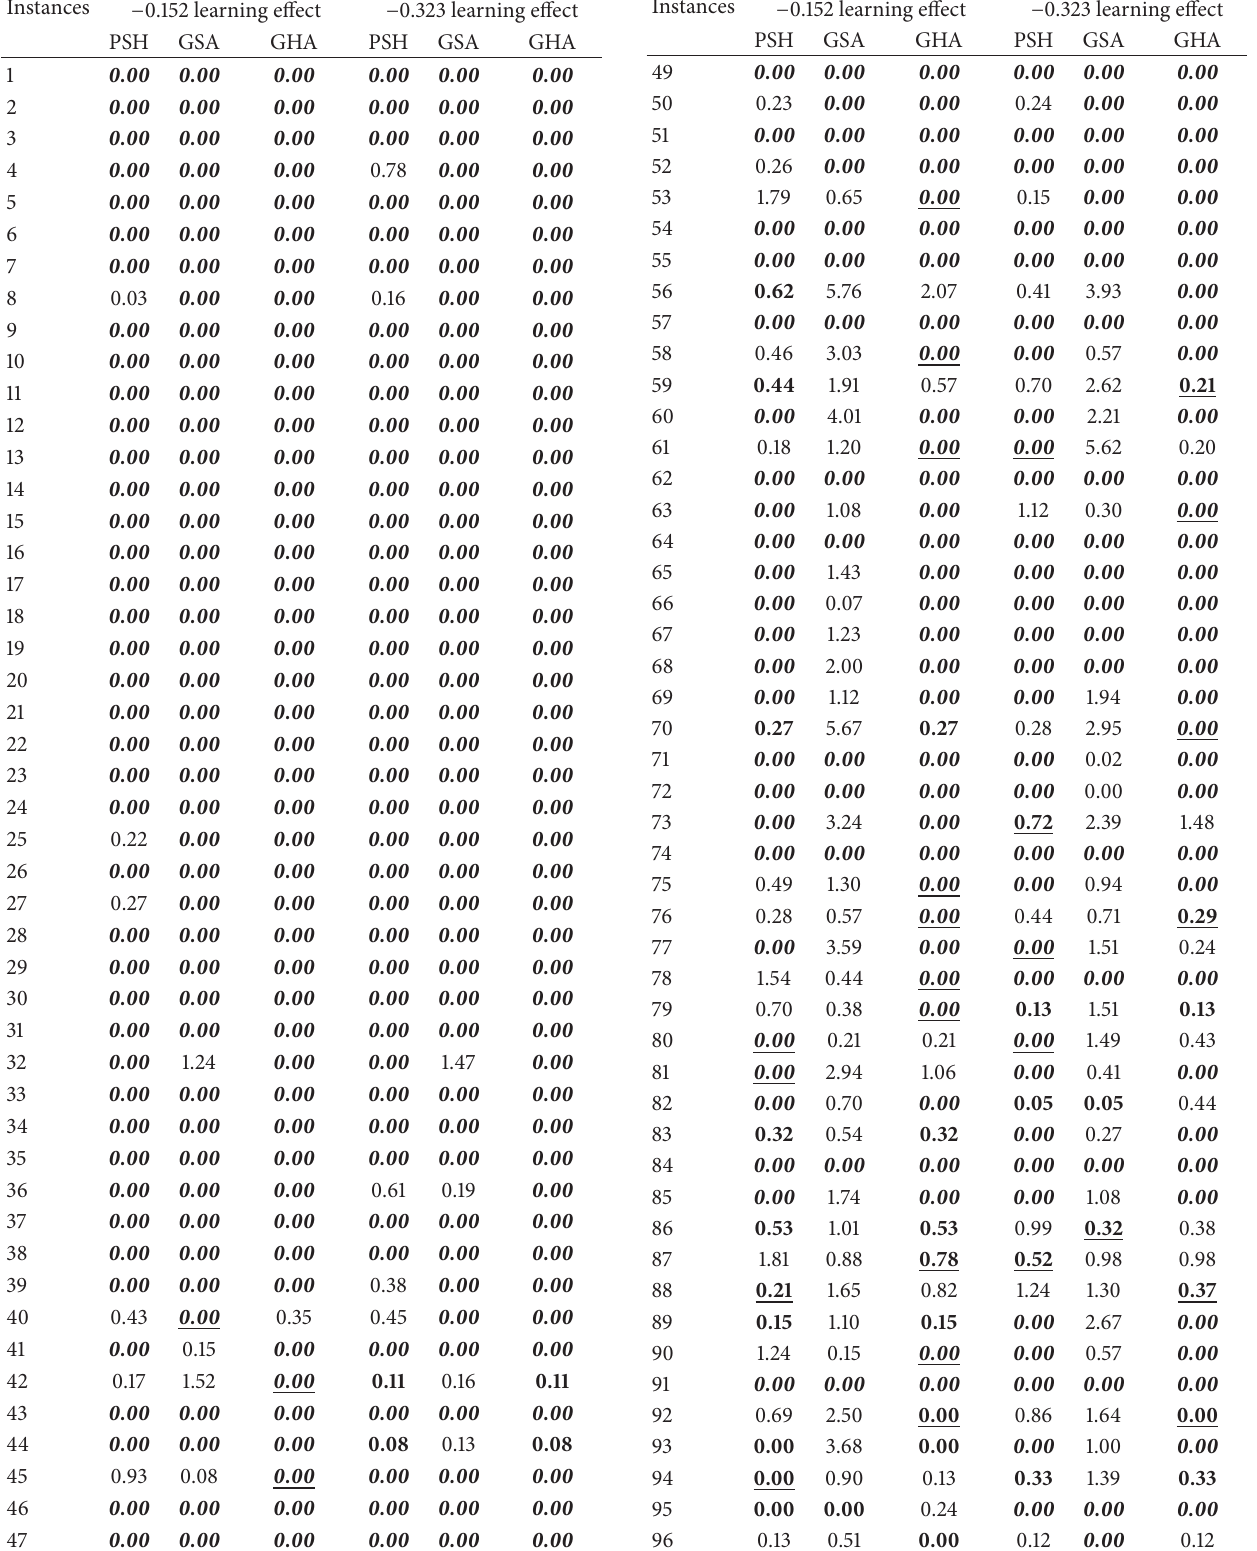
Table 5: Results of 3 machines